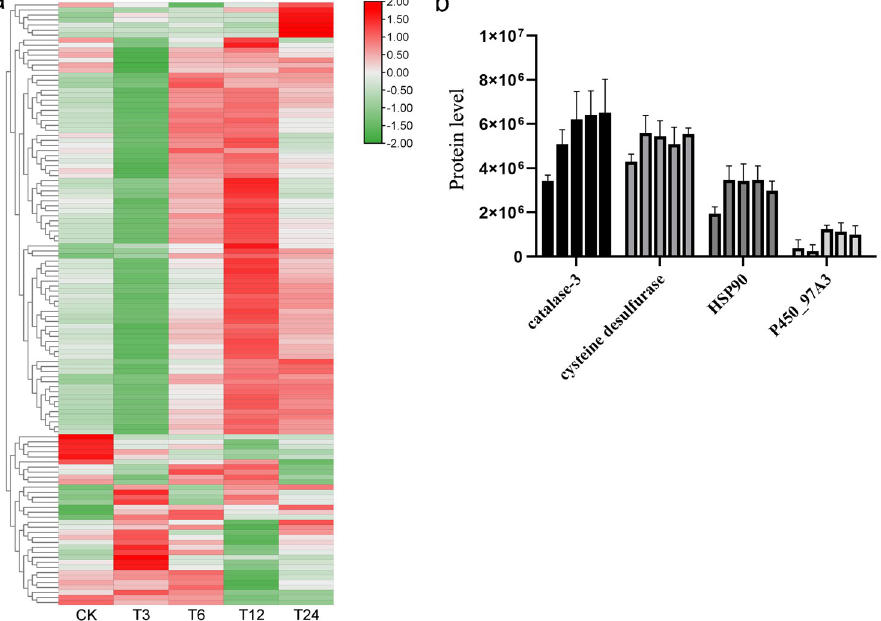
Fig 5. Key Differentially Expressed Proteins (DEPs) levels. (a). The levels of differential expressed proteins. The redder the color, the higher level of differential proteins. (b). The image shows the abundant of catalase-3 (CAT3, left- hand ordinate), cysteine desulfurase, HSP90 protein, and cytochrome P450_97A3 (left-hand ordinate).